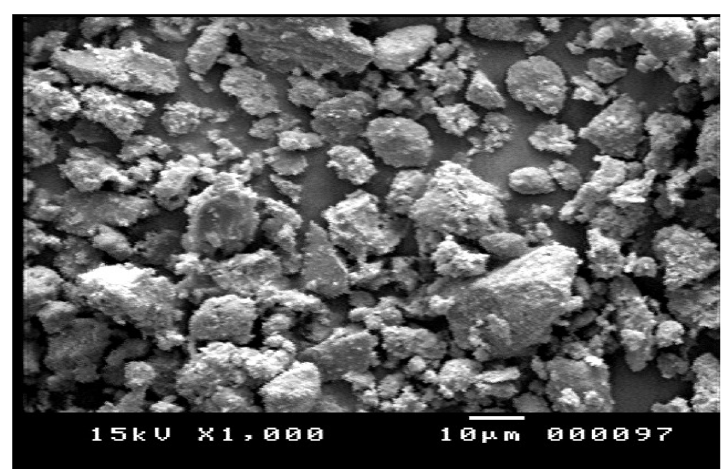
Fig. 5 SEM image of particles’ size in the dust sample